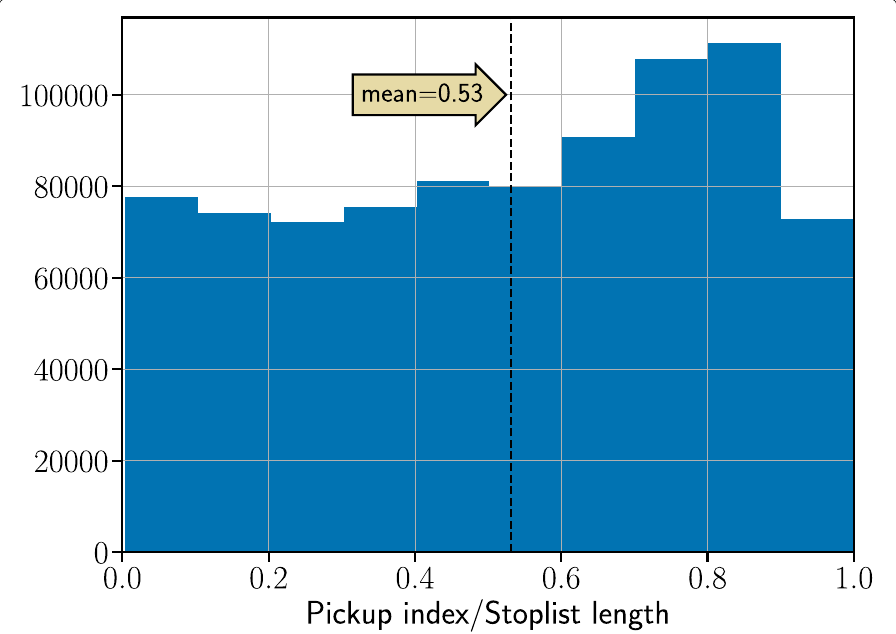
Pick-up location in a